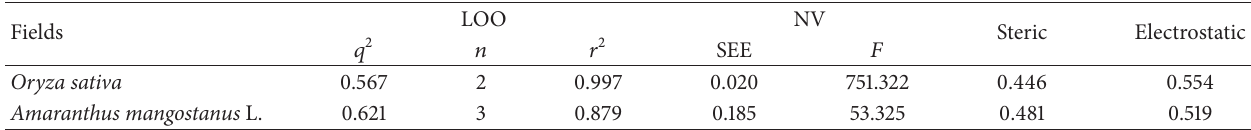
Table 3: Summary of CoMFA